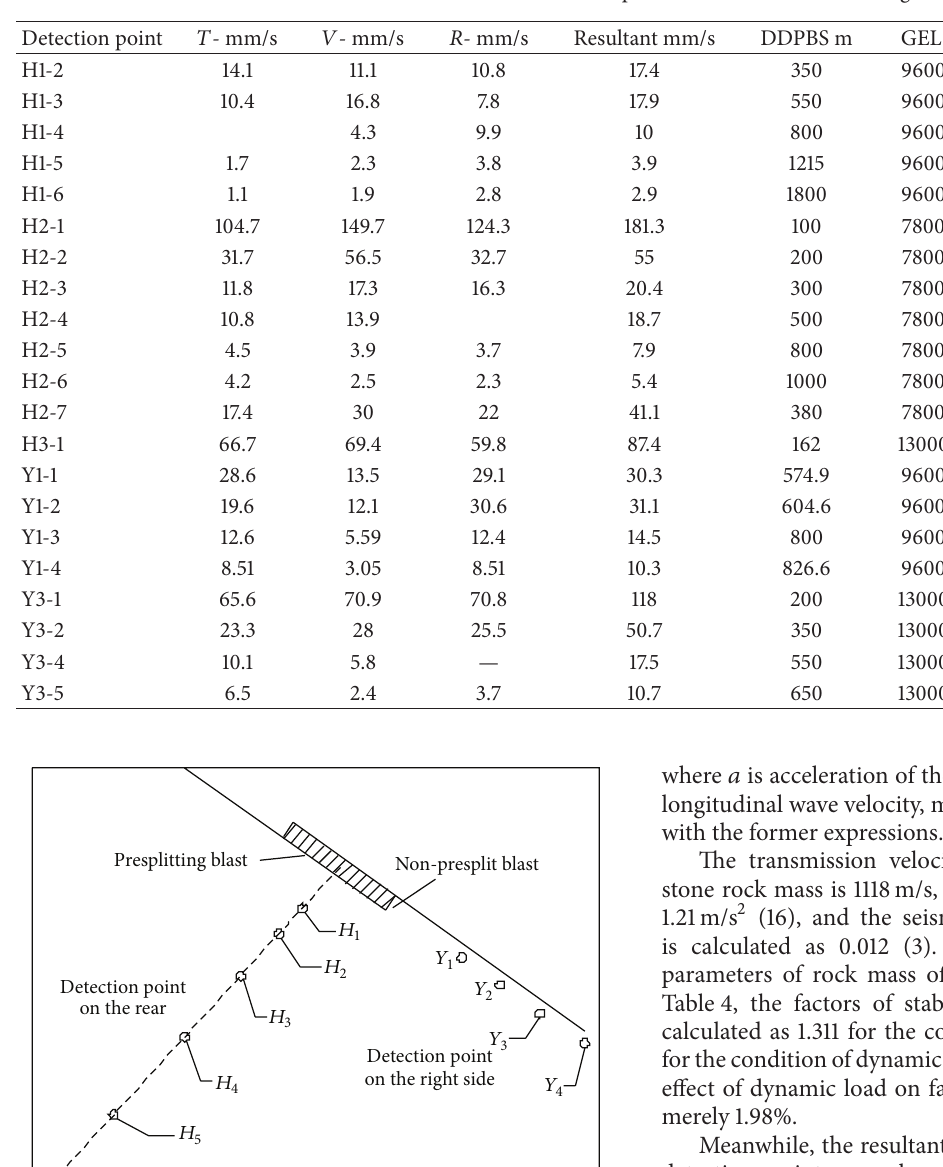
Table 3: Location of detection points and blast vibration strength.